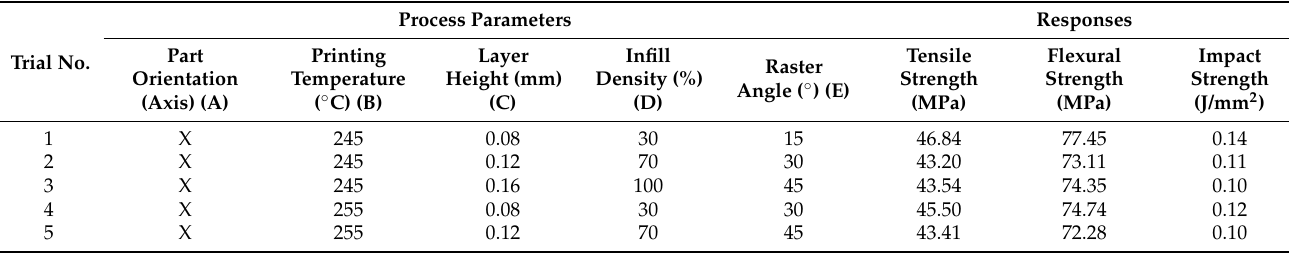
Table 4. Experimental design with output